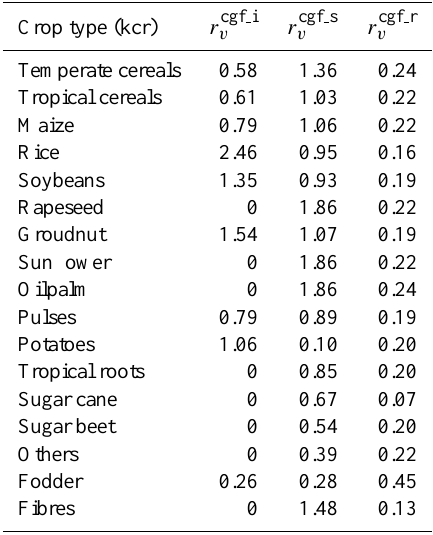
Table A4. N r contents of harvested crops ( r Nharvest